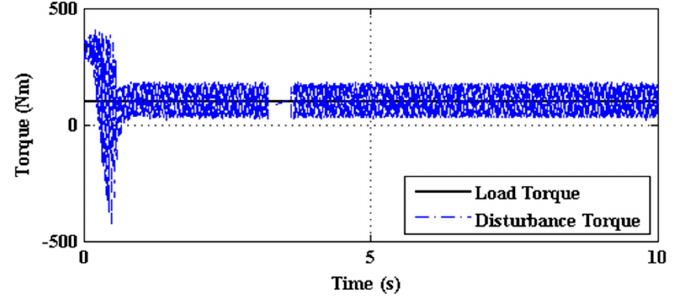
Figure 18. ( a ) estimated speed of SMLO 2 ( b ), zoomed version of ( a ).